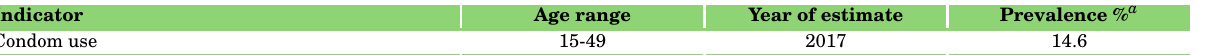
Table 48: Prevalence of condom use in